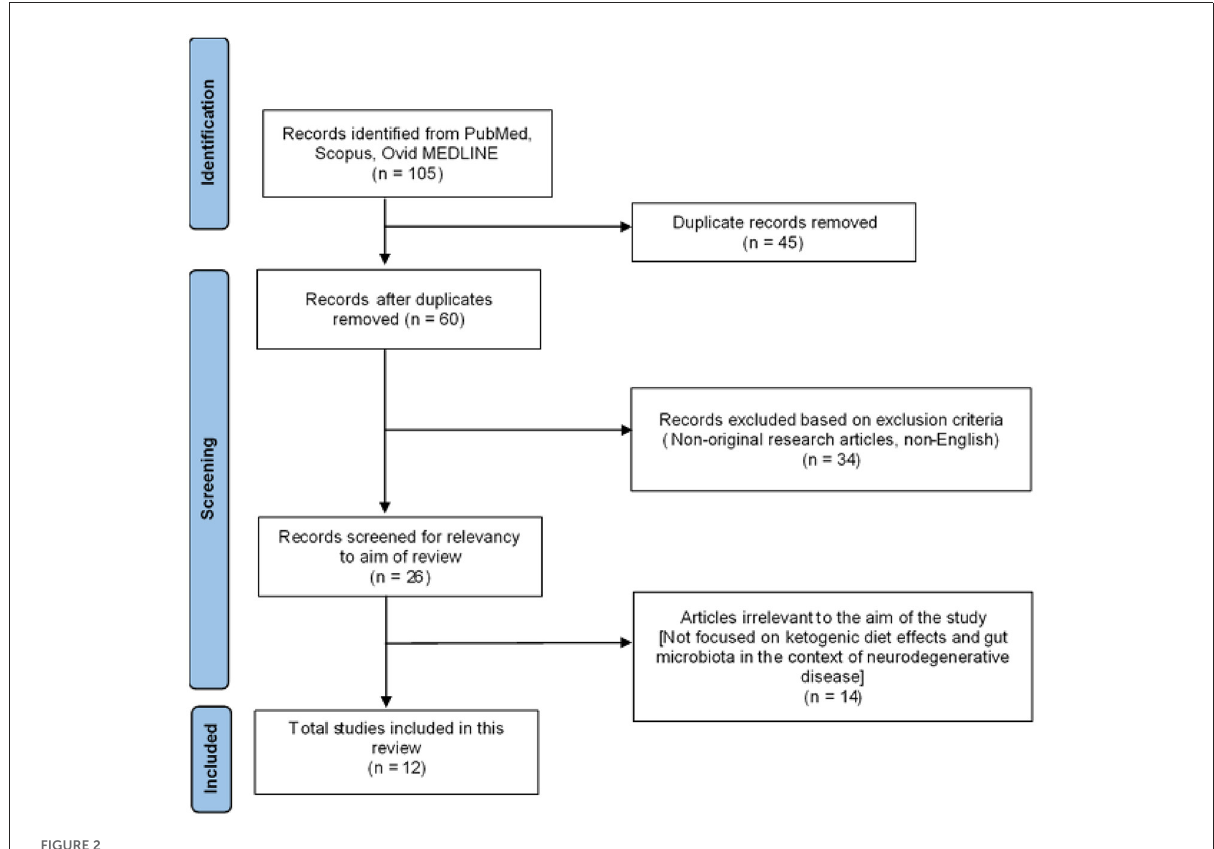
FIGURE2 PRISMA flowchart